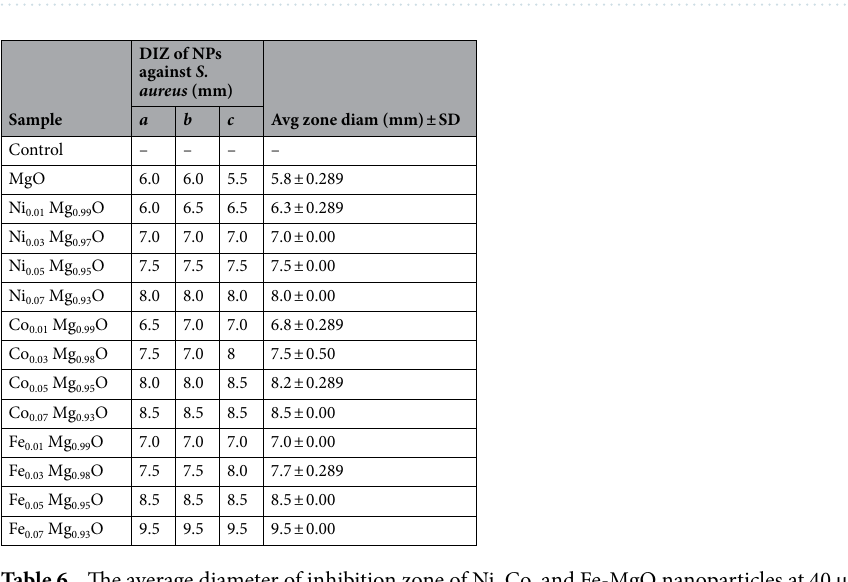
Figure 18. The average diameters of inhibition zone at 80 μg/ml of ( a ) Ni-doped MgO, ( b ) Co-doped MgO and ( c ) Fe-doped MgO nanoparticles with various doping concentrations of 0%, 1%, 3%, 5%, and 7%.